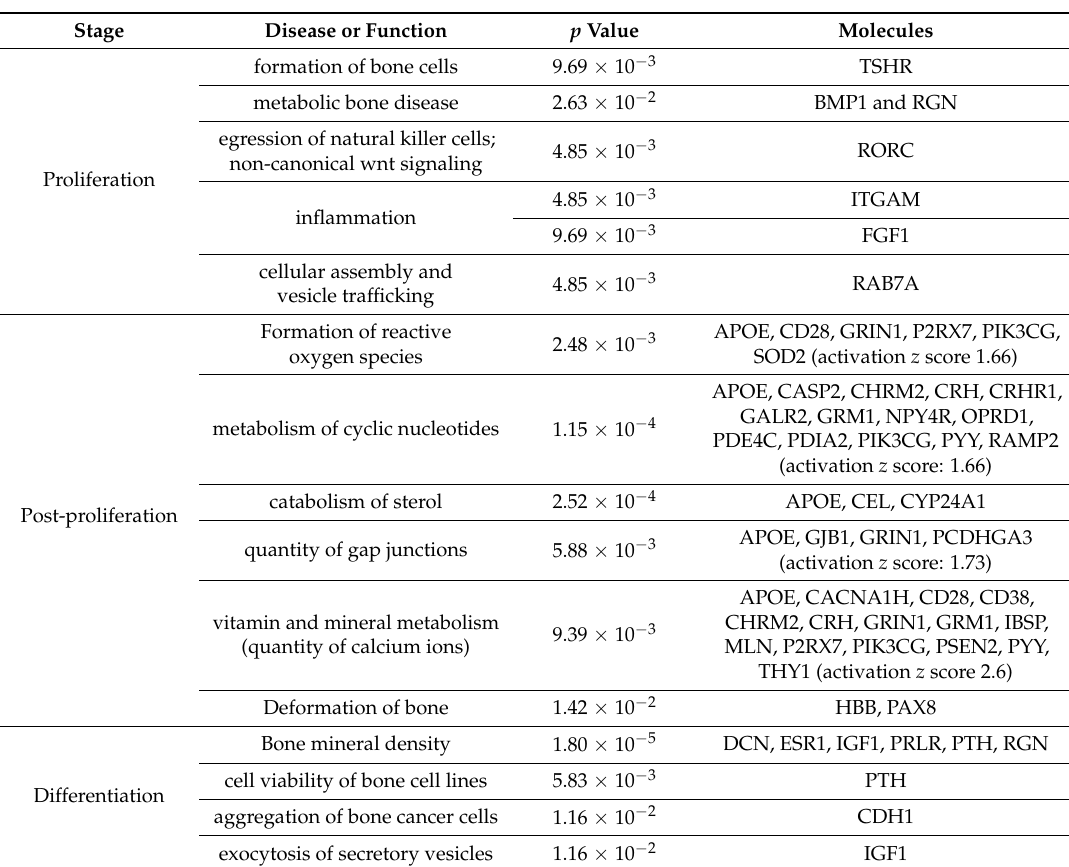
Table 1. Ingenuity pathway analysis (IPA) ranked vitamin D modulated biofunctions relevant to bone biology and bone tumor